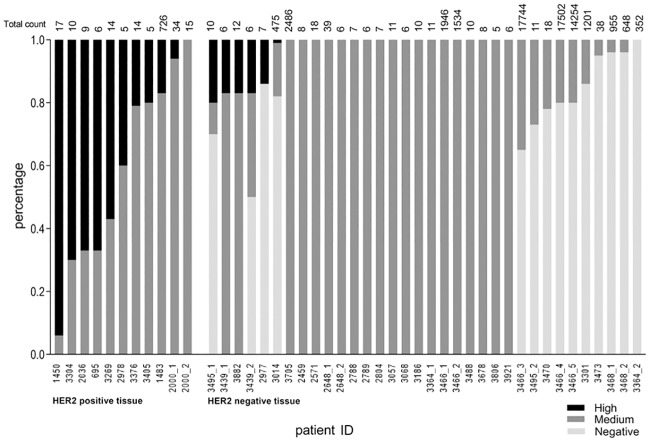
HER-2 IF scoring by ACCEPT of a MBC patient cohort.Percentage of HER-2neg, HER-2med, and HER-2high expressing CTCs in a MBC cohort divided in patients with HER-2-positive or -negative tissue (primary tumor and/or metastasis) samples. Total CTC count per sample is depicted on top. HER-2high expressing CTCs are present in at least 1 sample of 10/10 (100%) HER-2-positive patients, and 5/25 (20%) HER-2-negative patients.